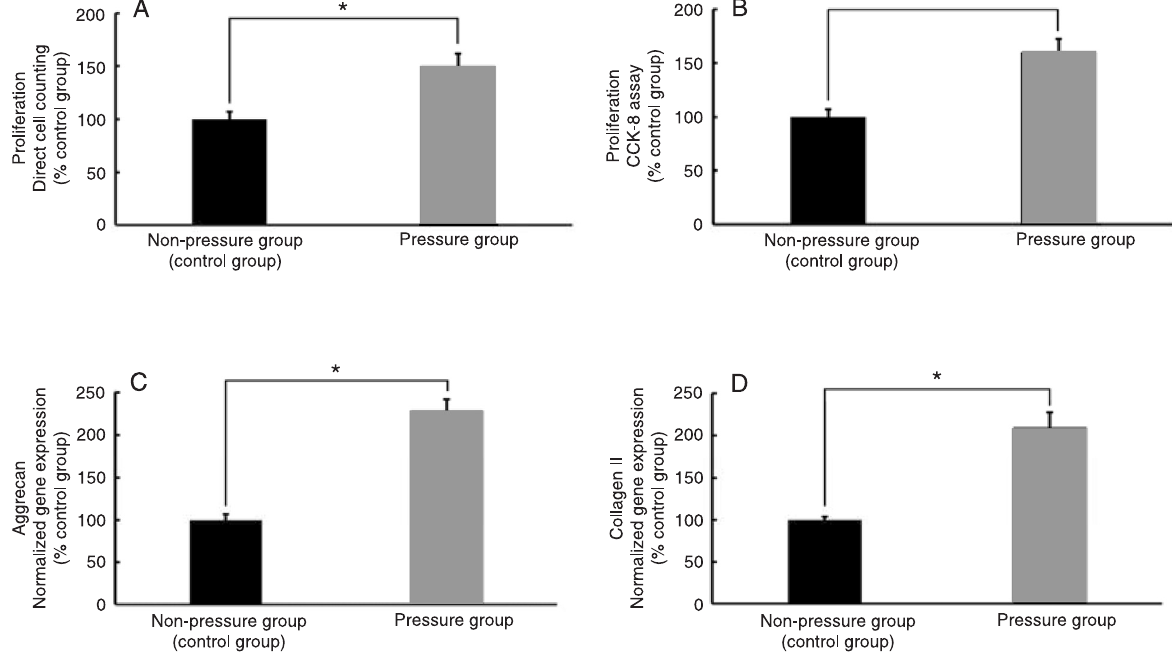
Figure 1. Effect of periodic mechanical stress on chondrocyte proliferation and matrix synthesis. Rat chondrocytes were cultured for 3 days under static conditions or conditions of periodic mechanical stress 8 h per day prior to proliferation studies. Cell proliferation was analyzed using direct cell counting ( A ) and a CCK-8 assay ( B ). Chondrocytes were cultured in vitro for 8 h, with or without periodic mechanical stress prior to matrix synthesis studies. Aggrecan ( C ) and type II collagen ( D ) gene expression were measured to indicate the level of matrix synthesis, which was measured by quantitative real-time PCR. Chondrocyte proliferation and matrix synthesis in the pressure group were significantly increased relative to that in the non-pressure group (N = 5, *P < 0.05, Student unpaired t